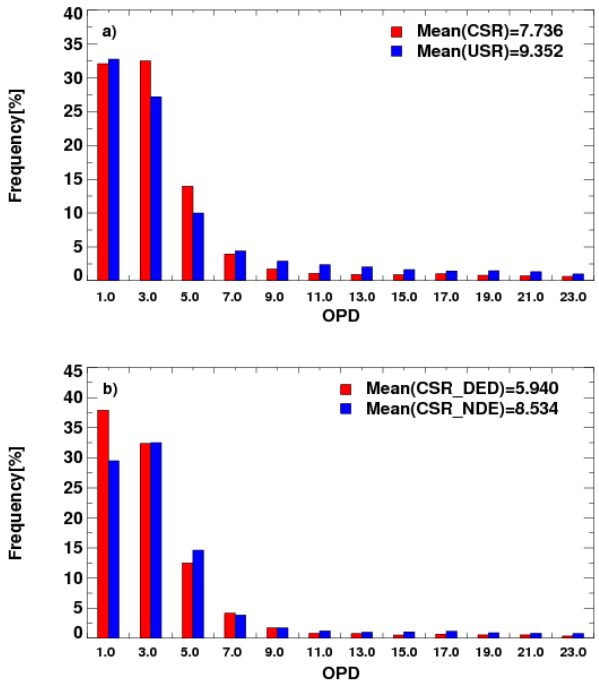
Fig. 8. Same as Fig. 5, but for optical depth (OPD). The histogram intervals are 2.